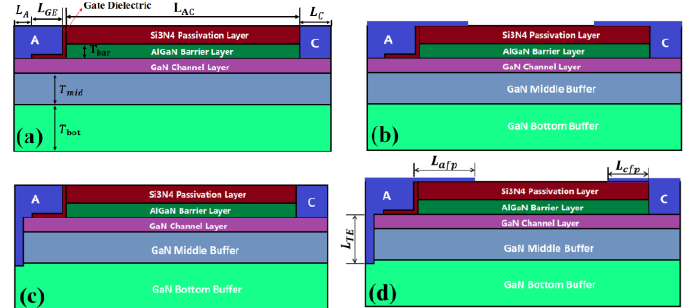
Figure 1. Cross-section of: ( a ) Schottky barrier diode (SBD) with gated edge termination (GET SBD), ( b ) SBD with gated edge termination in combination with field plates (GET FPs SBD), ( c ) T-anode located deep into the bottom buffer layer of the SBD (TAI-BBF SBD), ( d ) T-anode located deep into the bottom buffer layer of the SBD in combination with field plates (TAI-BBF FP SBD).